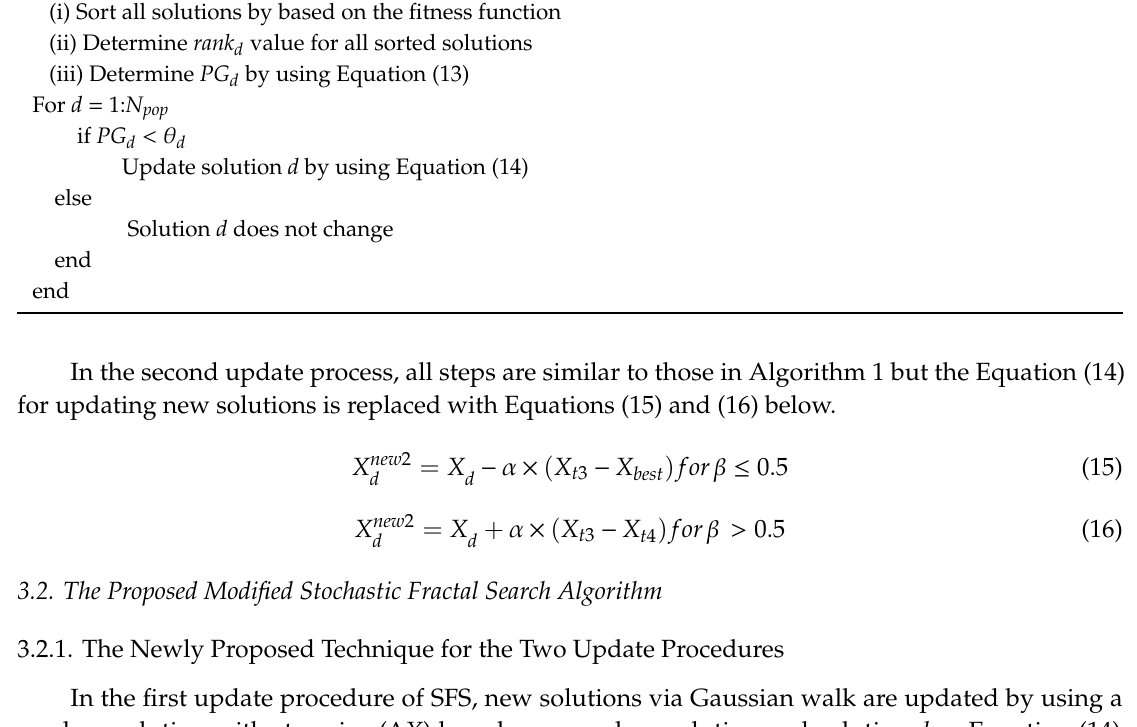
Algorithm 1. The first update process of SFS